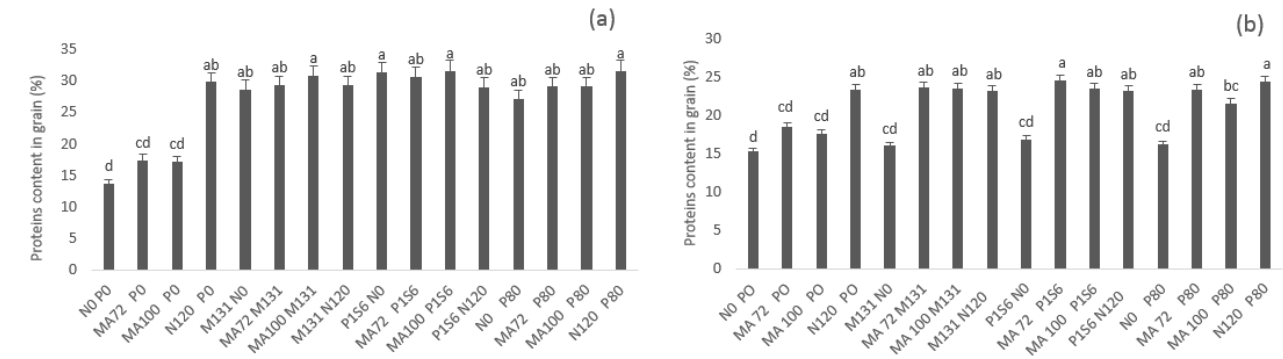
Figure 5. Effect of co-inoculation with Mesorhizobium spp. (MA72 or MA100) and Bacillus sp. (M131) or E. aerogenes (P1S6) and phosphate application combined to rhizobial inoculation on proteins content in grain of Chickpea in Merchouch ( a ) and Ain Sbit ( b ). Bars followed with the same letter are not significantly different at α = 0.05. (P80 indicate application of 80 kg P2O5/ha, N120 indicate application of 120 kg N /ha, N0, and P0 indicate no nitrogen and phosphate chemical fertilizers